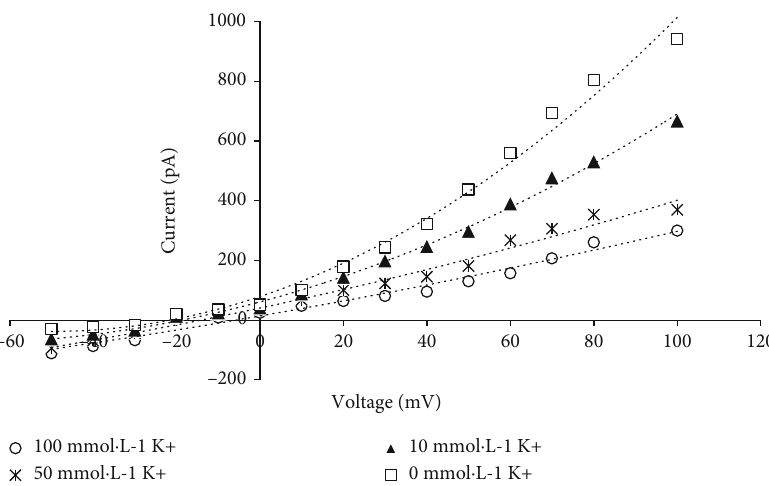
Figure 6: Curves of the current-voltage relation recorded by patch clamping system. Green fl uorescence-labelled HEK293-T cells that transformed with pTracer-CMV3- SKOR were being detected by PCLAMP 10.0 device. The current signal was recorded by PCLAMP 10.0 and calculated by Sigma plot 11.0. The K + concentration in the extracellular fl uid was chosen as 0, 10, 50, and 100 mmol · L -1 . Data are shown as the means recorded from 5 independent